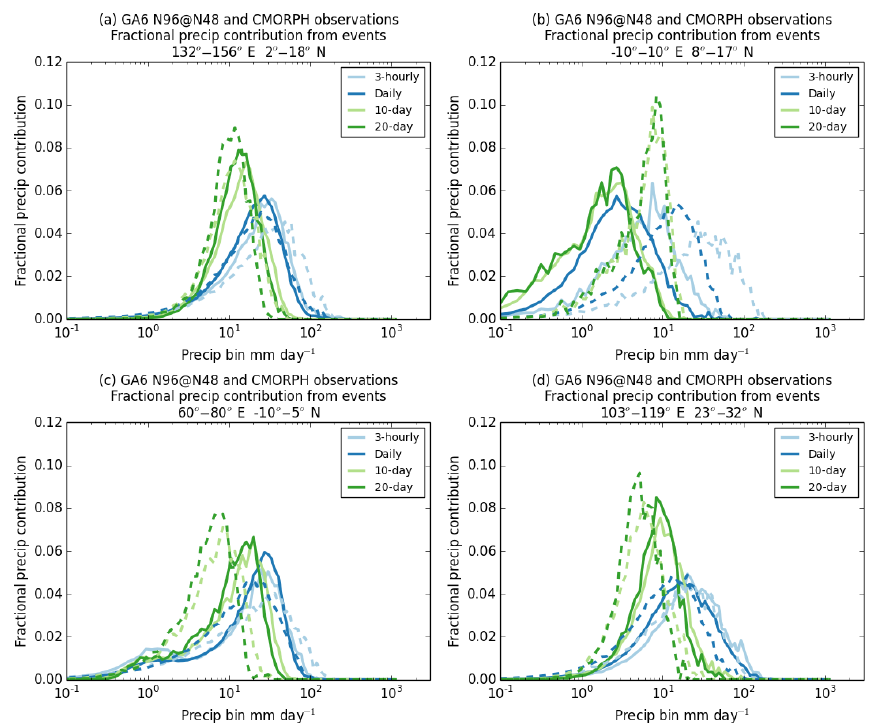
Figure 10. Spectra of 3-hourly, daily, 10-day and 20-day rainfall totals (in mmday − 1 ) from the MetUM-GA6 N96 configuration (solid lines), averaged over four regions: (a) “WP” domain; (b) “WA” domain, (c) equatorial Indian Ocean (10 ◦ S–5 ◦ N, 60–80 ◦ E) and (d) southern China (23–32 ◦ N, 103–119 ◦ E). Corresponding spectra from CMORPH are shown by the dashed lines. Rainfall data were first averaged to the N48 grid in both